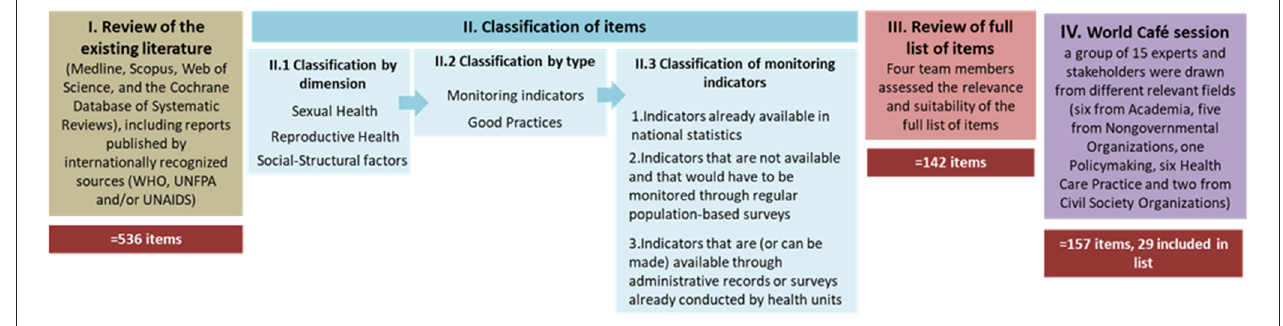
FIGURE 3 | Development of the Delphi